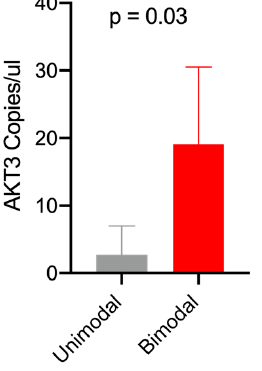
Figure 4. Differential expression of AKT3 mRNA in unimodal and bimodal EOC cell lines.